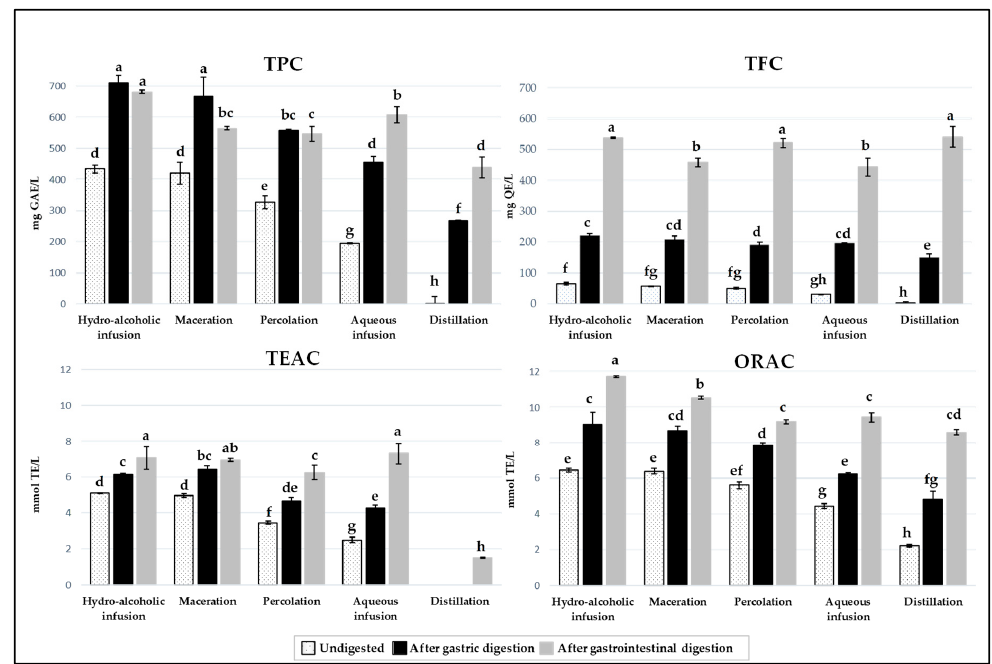
Figure 3. Total phenolic (TPC) and flavonoid (TFC) contents and antioxidant capacity measured by Trolox equivalent antioxidant capacity (TEAC) and oxygen radical absorbance capacity (ORAC) assays of carob liqueurs obtained with different extraction methods and subjected to gastrointestinal digestion. In each graph (TPC, TFC, TEAC or ORAC), values marked with different letters indicate a significant difference ( p < 0.05).